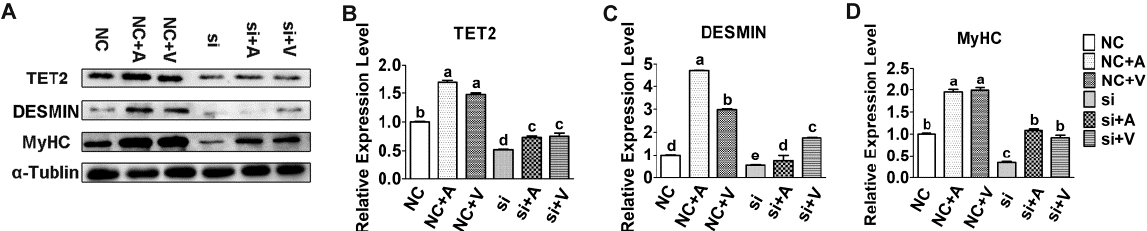
Figure 3. Tet2 knockdown inhibited myoblast differentiation induced by 5-AZA and VC. ( A ): Protein level of TET2, DESMIN and MyHC was analyzed after Tet2 knockdown. ( B – D ): The gray analysis of relative protein expression. Data are presented as the means ± SEM. Different letters indicate significant differences ( p < 0.05).